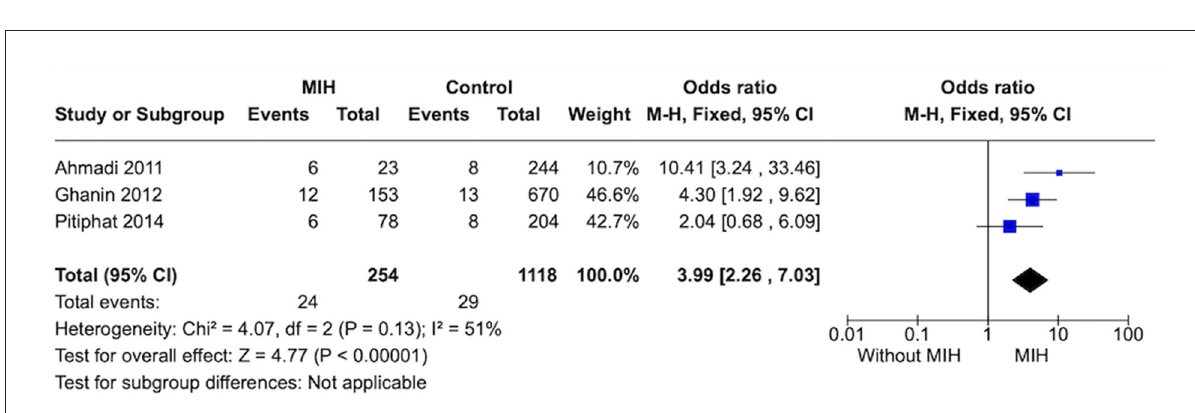
FIGURE4 Forest plot of meta-analysis for the prevalence of tonsilitis among subjects with MIH. CI, confidence interval.